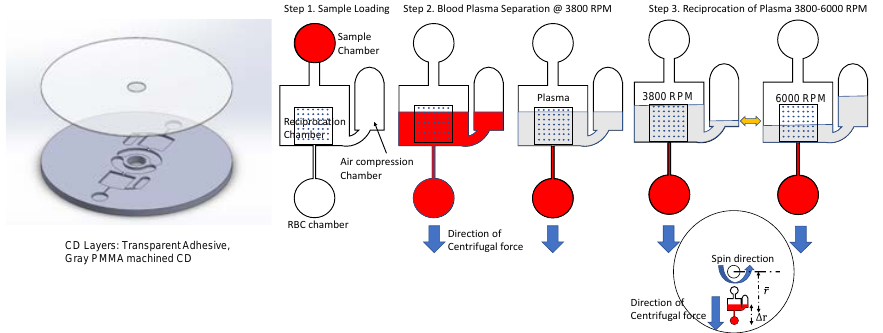
Figure 1. Design and operation of the integrated CD (inset on the bottom demonstrate the orientation of the fluidic network on the CD). Sequence of process steps include: Step 1—loading of the whole blood into the sample chamber; Step 2—spin at 3800 rpm for 4 min to separate red blood cells